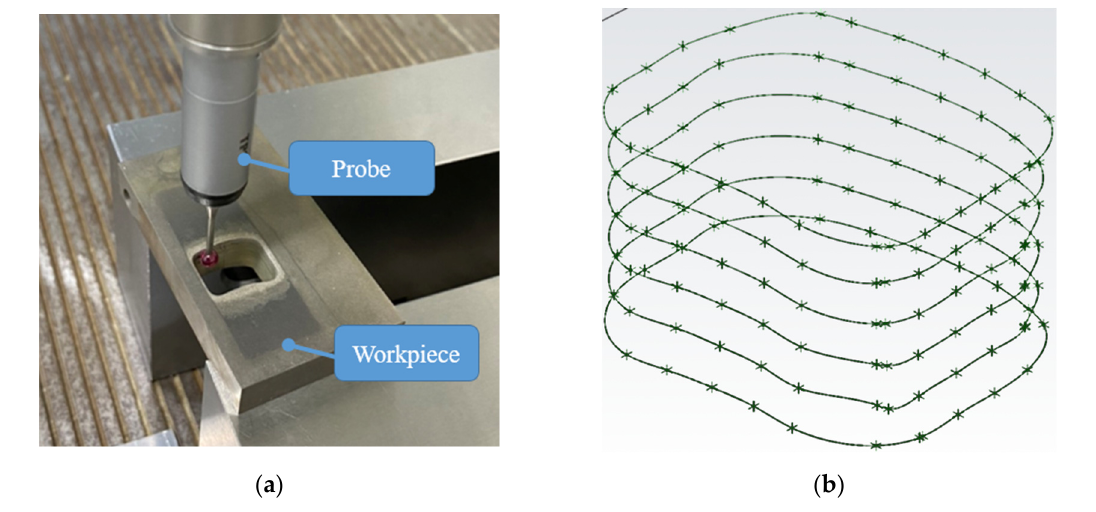
Figure 3. ( a ) workpiece and measurement ;( b ) workpiece processing view. Table 2. Measurements after ECM